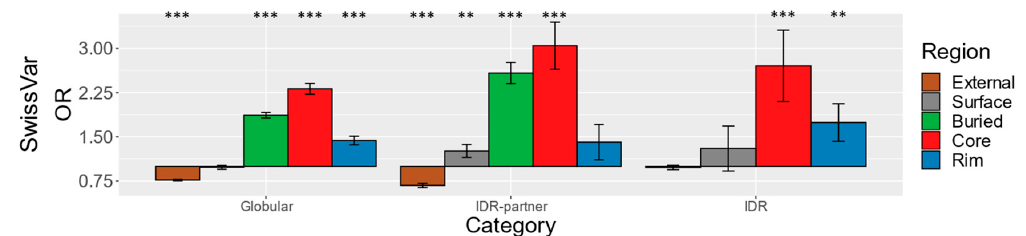
Figure 2. Odds ratios of SwissVar single nucleotide variants (SNVs). An odds ratio (OR) is calculated for each protein region using all residues in the dataset as the reference distribution. The bar graph plots the ORs ( Y -axis) of each protein category and protein region ( X -axis). Each OR is the odds of mutation in the specific region divided by the odds of the full-length parent proteins. The Y -axis is centered at one, and ORs > 1 show enrichment while ORs < 1 show depletion. Structural regions are color-coded (see Figure 1). Statistical significance is denoted by asterisks: * p -value < 0.05, ** p -value < 0.01, *** p -value < 0.001. ORs and p -values can be found in Supplementary Table S2.